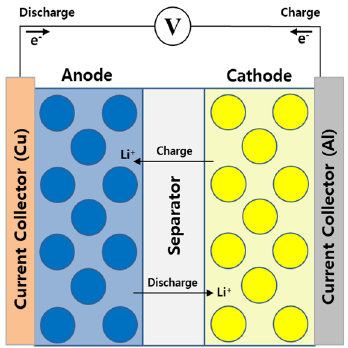
Figure 1. Schematic of the Li-ion battery.